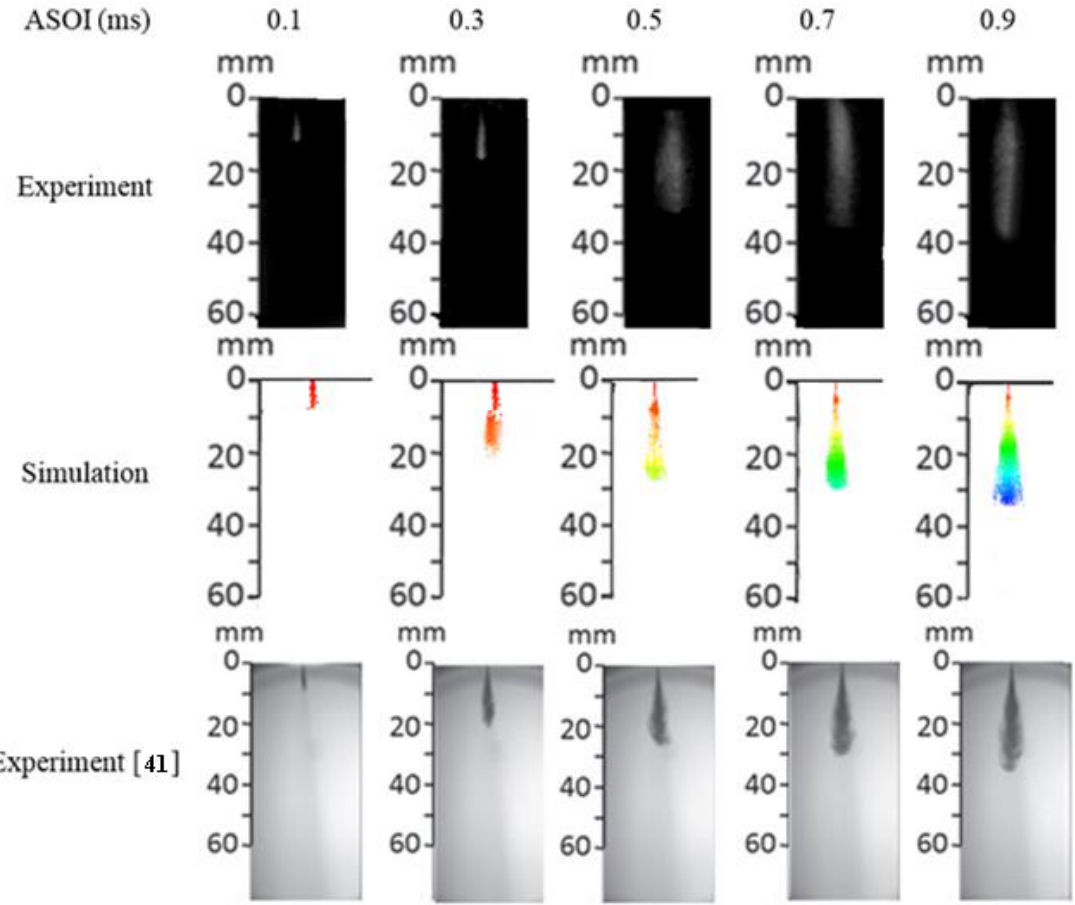
Figure 9. Comparison of the spray characteristic between simulation and experimental results.